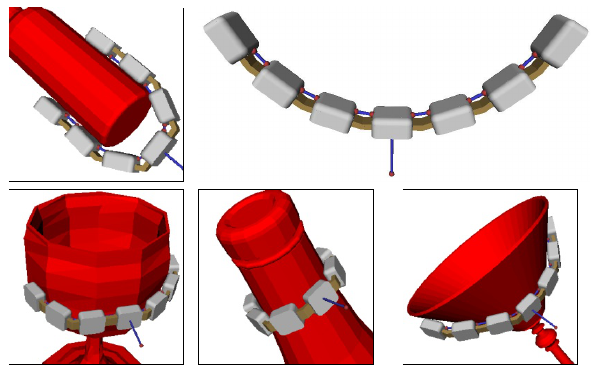
Fig. 5. GRIPPER MODEL FOR GRASPIT! AND EXAMPLES Figure 5. Gripper model for graspit! and examples of grasps from OF GRASPS FROM THE OPTIMIZATION POOL. the optimization